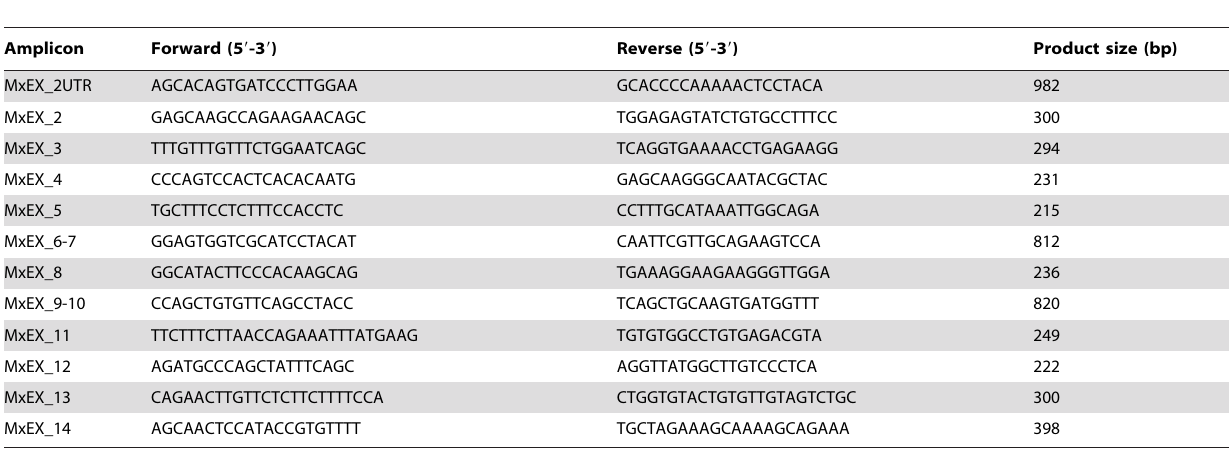
Table 1. Primers used for amplification and